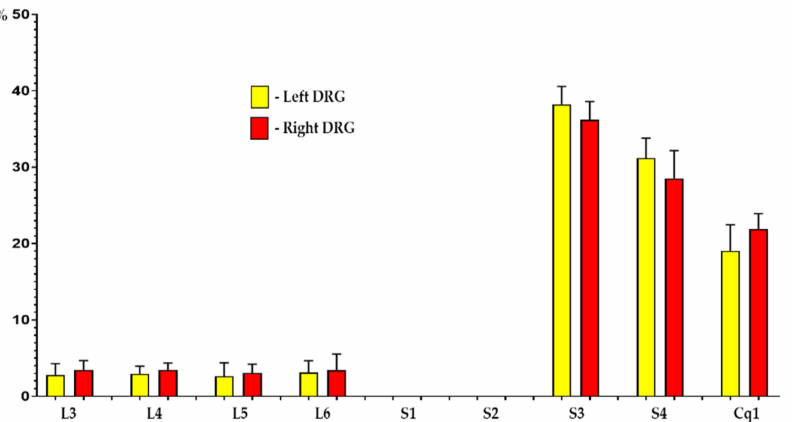
Figure 3. Bar diagram showing the distribution pattern of FB-positive, bladder projecting cells in the porcine DRG ipsi- (red bars) and contralateral (yellow bars) to the sites of tracer injections into the organ wall of guanethidine (GUA)-treated animals. Data are pooled and presented as mean ±